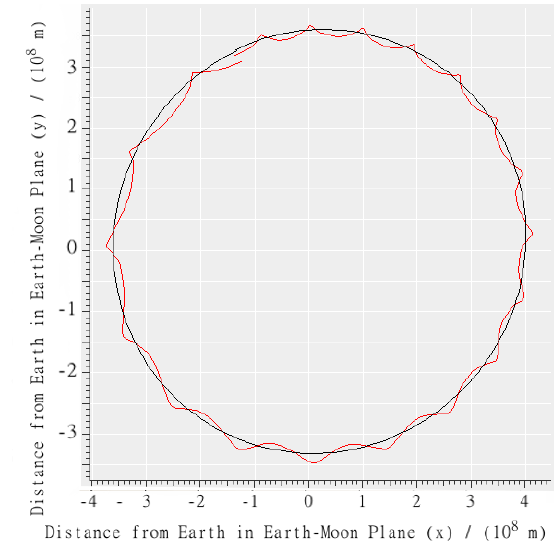
Figure 13. A characteristic trajectory over 1 month from the left-edge of the main stable zone in earth-centered coordinates. The black line (smooth circular shape) represents the trajectory of Moon. The red line (irregular pattern) represents the trajectory of a vehicle that was ultimately stable for 30